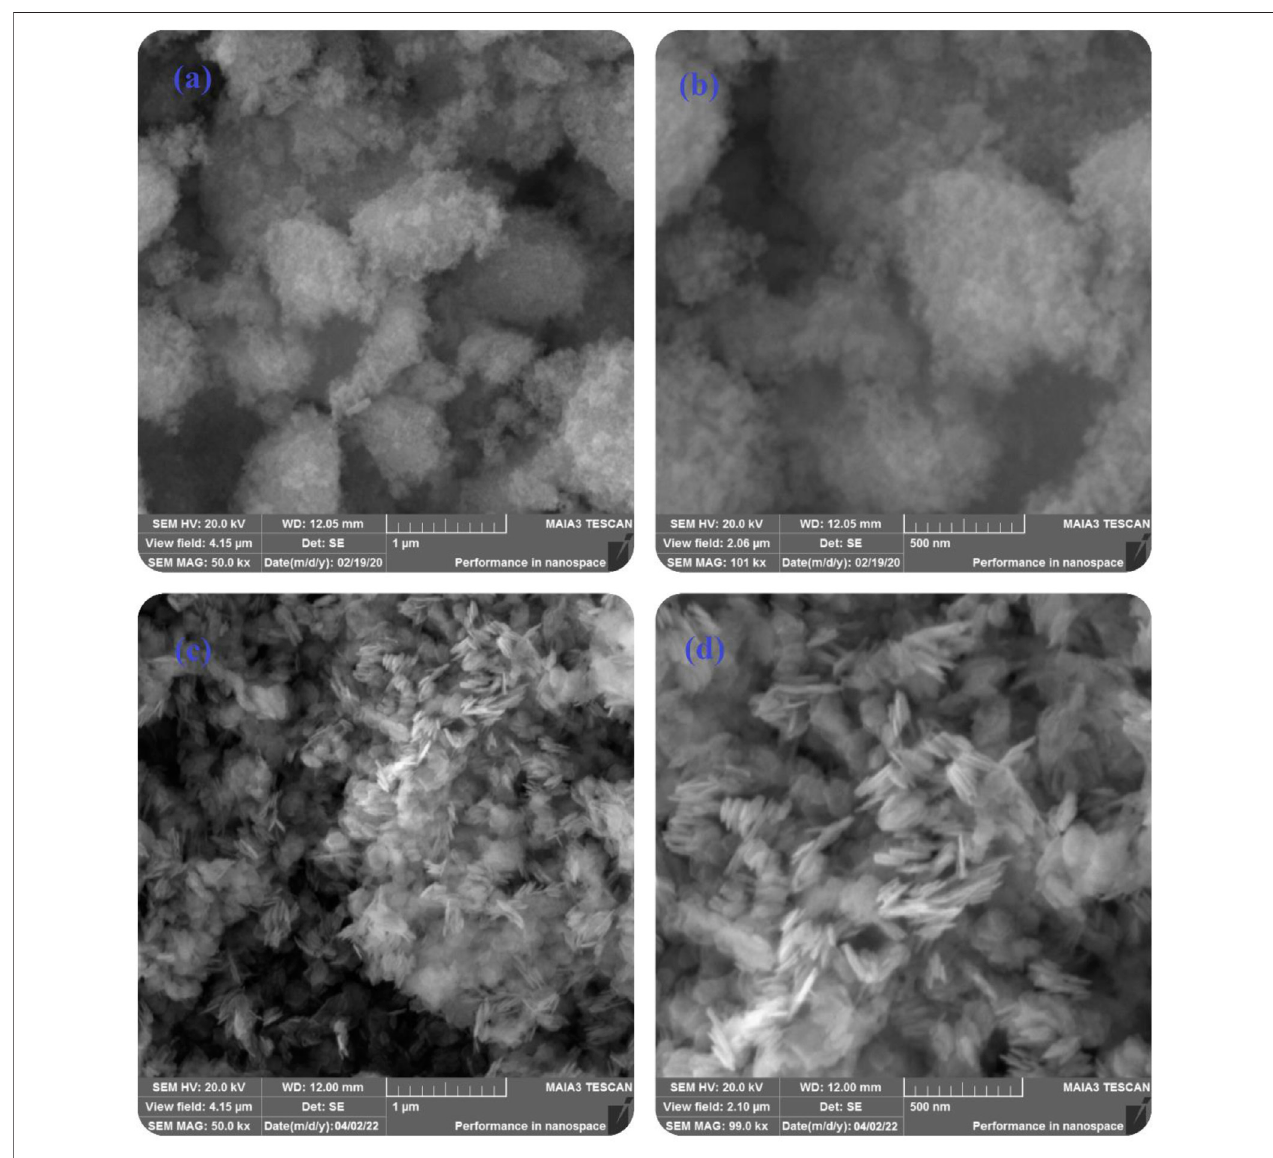
FIGURE 2 | Low and high magni fi cations SEM micrographs of (A,B) pure ZnO, (C,D) B-doped ZnO-NSs.